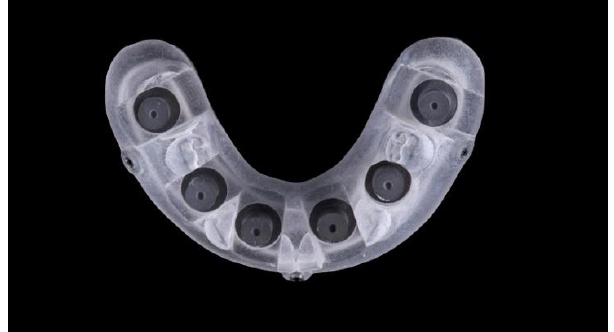
Figure 7. Titanium model (four implants) with a prosthetic template screwed.